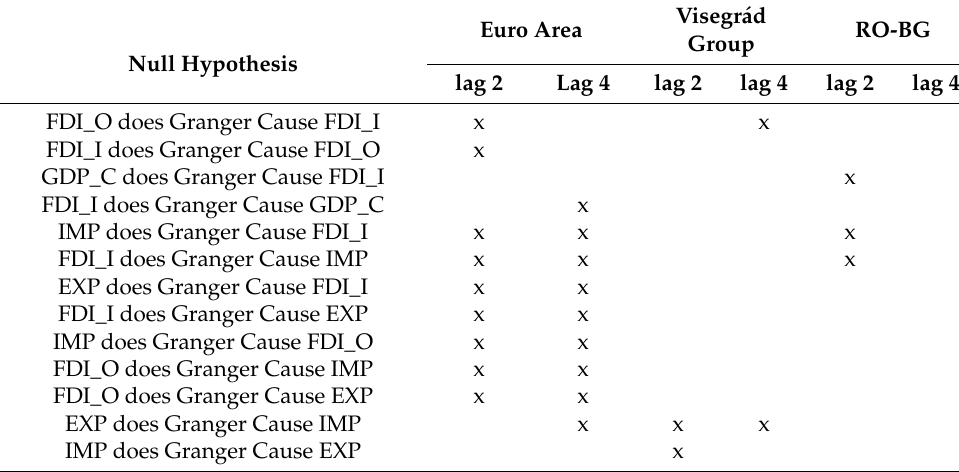
Table 4. Confirmed links by Granger pairwise causality